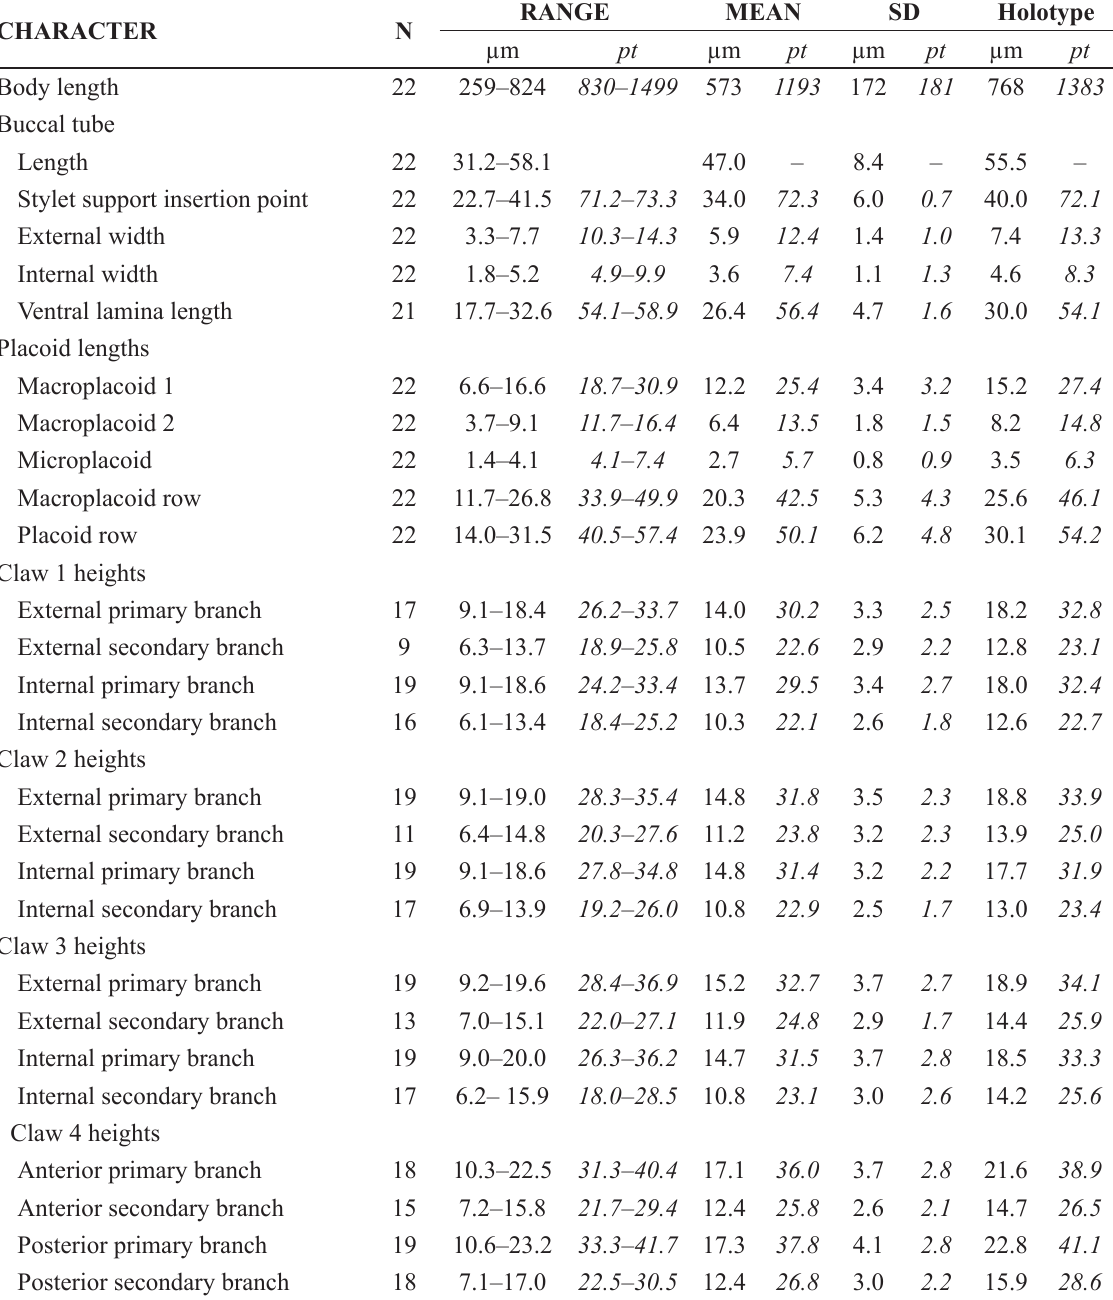
Table 4. Measurements (in μm) and pt values of selected morphological structures of the holotype and paratypes of Tenuibiotus zandrae sp. nov. mounted in Hoyer’s medium. (N: number of specimens/ structures measured; RANGE refers to the smallest and the largest structure among all measured specimens; SD: standard